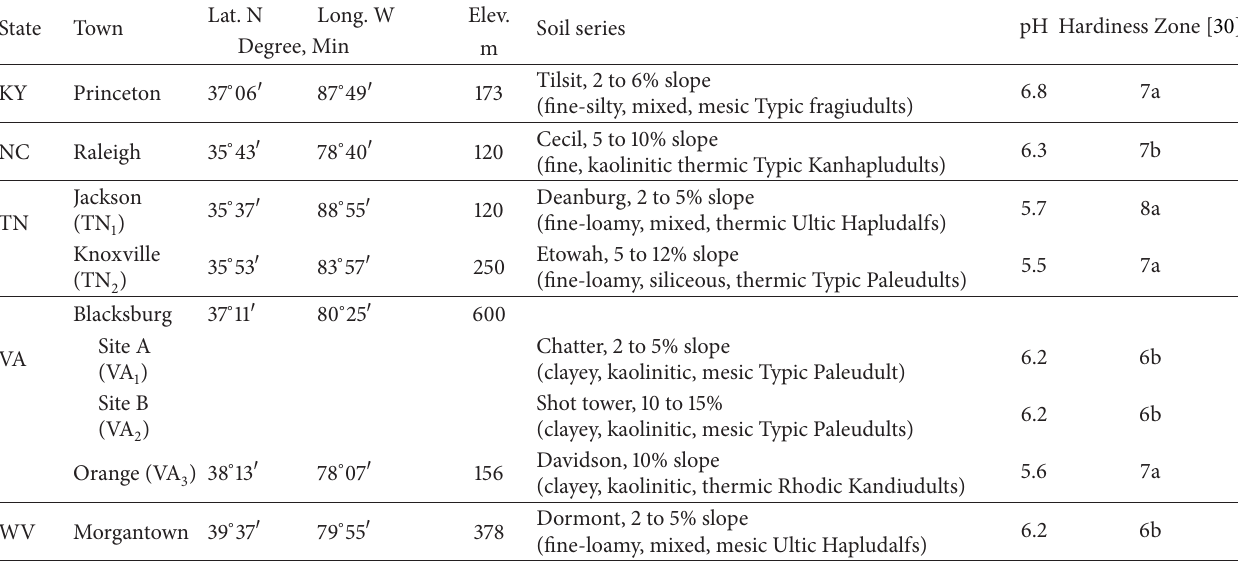
Table 1: Location, elevation, soil series, pH, and hardiness zones of sites where switchgrass varieties were evaluated as a biofuels crop in 2000 and 2001. The pH values collected in 1992 during the establishment of the switchgrass plots at all locations.